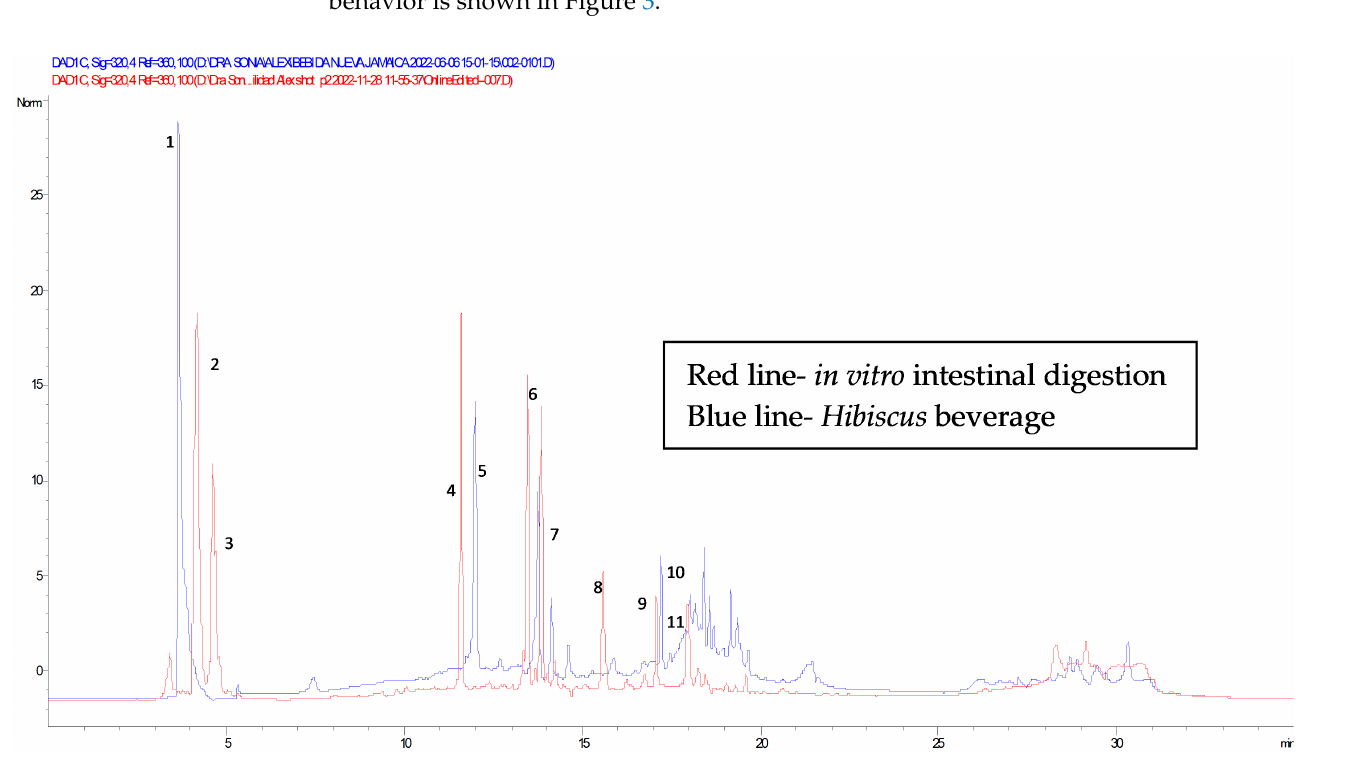
Figure 3. Chromatograms of bioactive compounds (BC) identified by HPLC-DAD of the Hibiscus beverage in the initial phase, and chromatogram of BC released during in vitro intestinal digestion. CB detected: 1–2 hibiscus acid, 3 hydroxycitric acid, 4–5 caffeoylquinic acid, 6–7 chlorogenic acid, 8 caffeic acid, 9–10 caffeoylshikimic acid III, 11 quercetin-galloylhexoside.